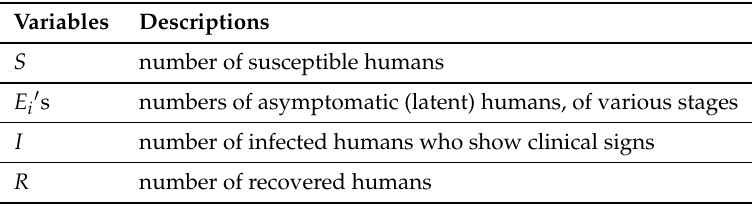
Table 1. Variables used in our